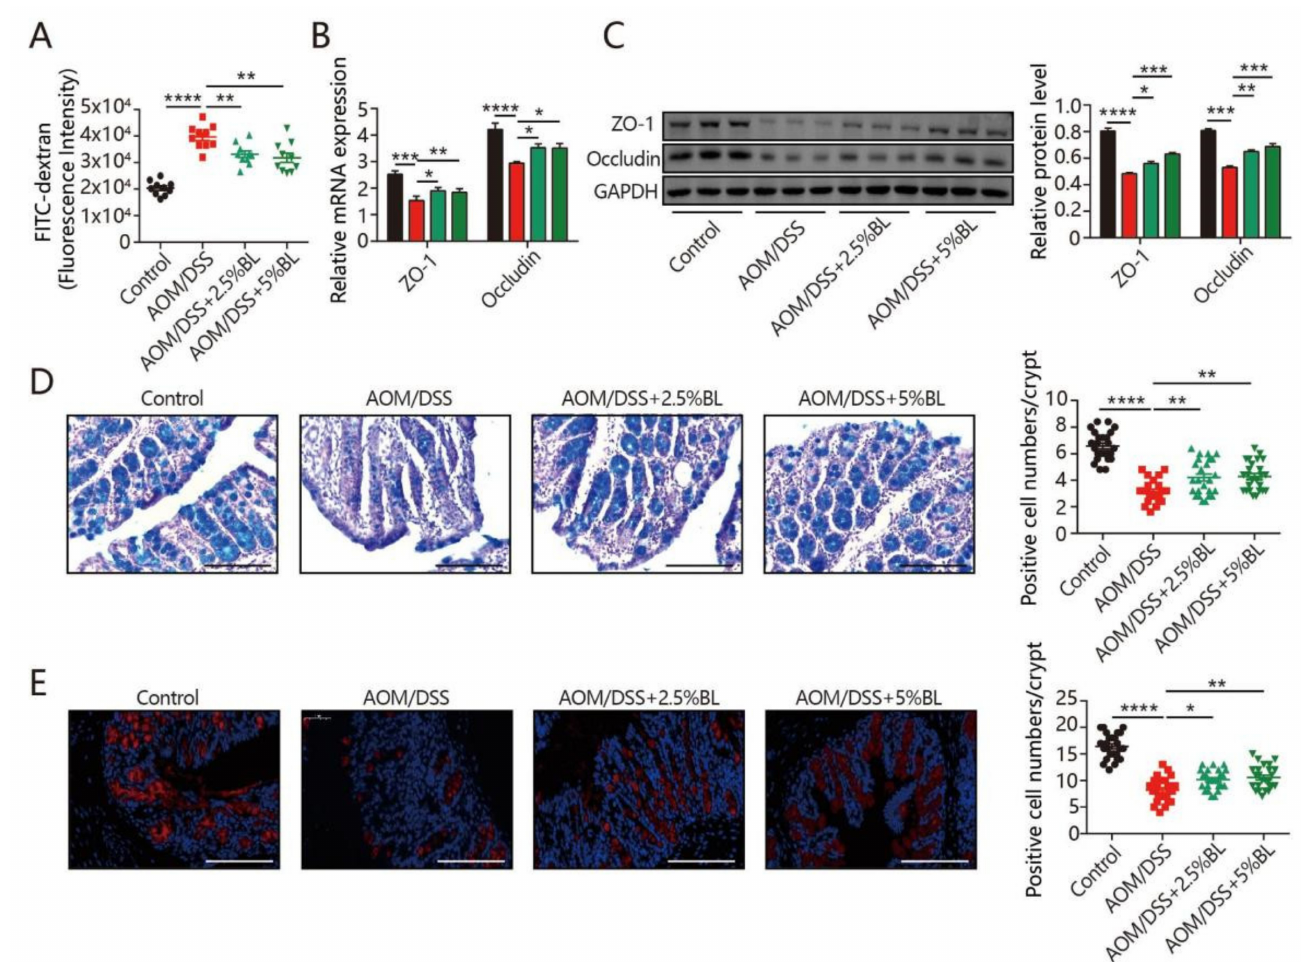
Figure 3. BL protects against AOM/DSS-induced intestinal barrier dysfunction. ( A ) Intestinal permeability, and ( B , C ) the expression of zonula occludens-1 (ZO-1) and occludin in the colonic tissues ( n = 8–10). ( D ) AB staining and colonic goblet cell numbers were quantified (400 × ). ( E ) Immunofluorescent analysis of Muc-2 (red) in mouse colonic sections (400 × ). Data are mean ± SEM. * p < 0.05, ** p < 0.01, *** p < 0.001 and **** p < 0.0001. The statistics were performed with one-way ANOVA. BL, barley leaf; AOM, azoxymethane; DSS, dextran sodium